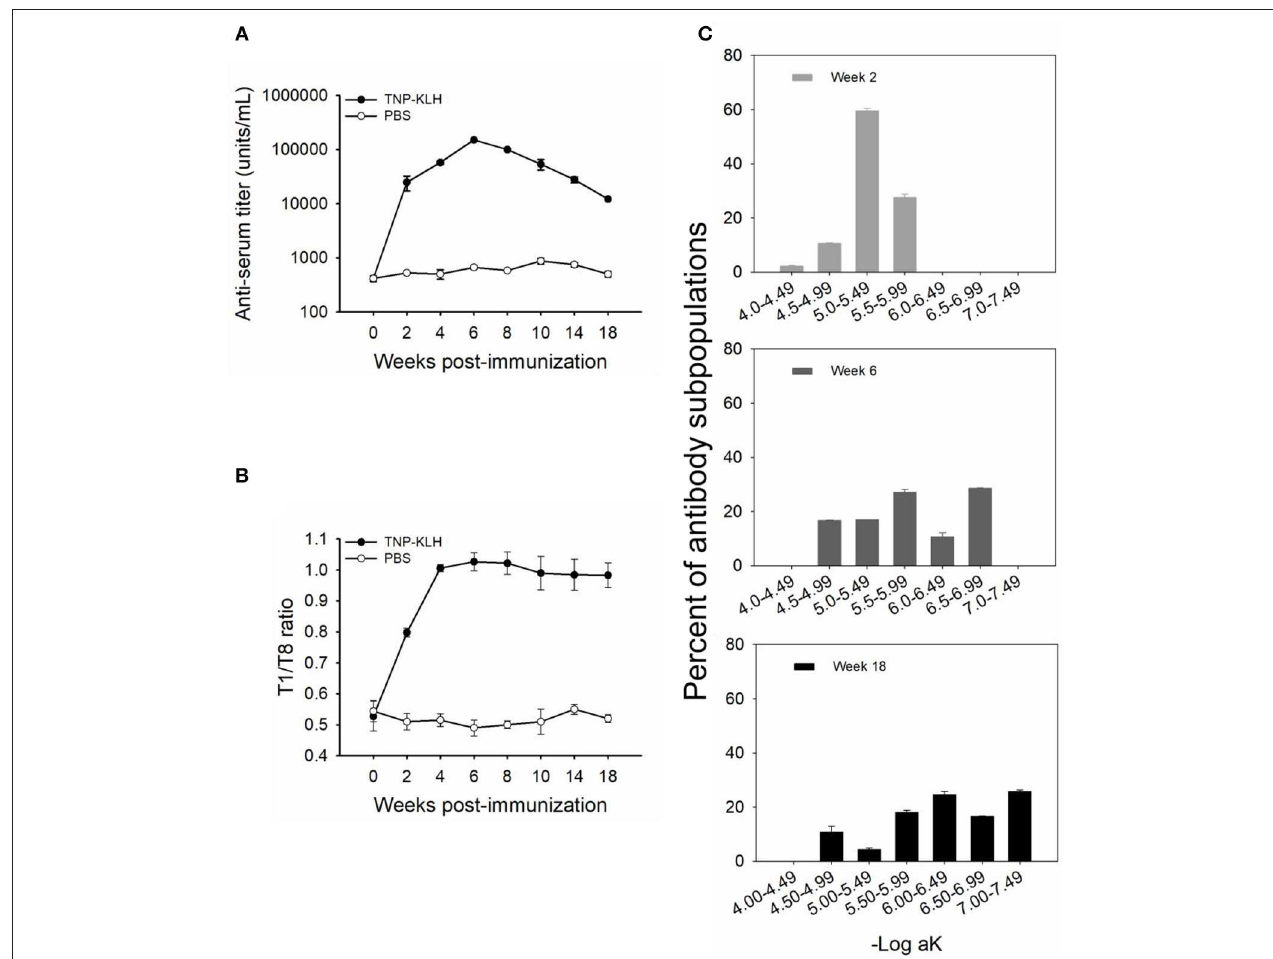
FIGURE 1 | Anti-TNP antibody titers and affinities induced by trinitrophenylated-keyhole limpet hemocyanin (TNP-KLH) ( n = 5). The dynamics of anti-TNP antibody titers were detected by standard antibody titration ELISA (A) . The T1/T8 ratio was used to present the dynamic of antibody maturation (B) , and affinity partitioning ELISA (C) was used to detect the differential dynamics of antibody subpopulations at weeks 2, 6, and 18 post-immunization. Week 0 was bled prior to immunization, and PBS was immunized as the control. Data represent the mean ± standard deviation (SD) of five individual fish at each time point and are representative of three independent